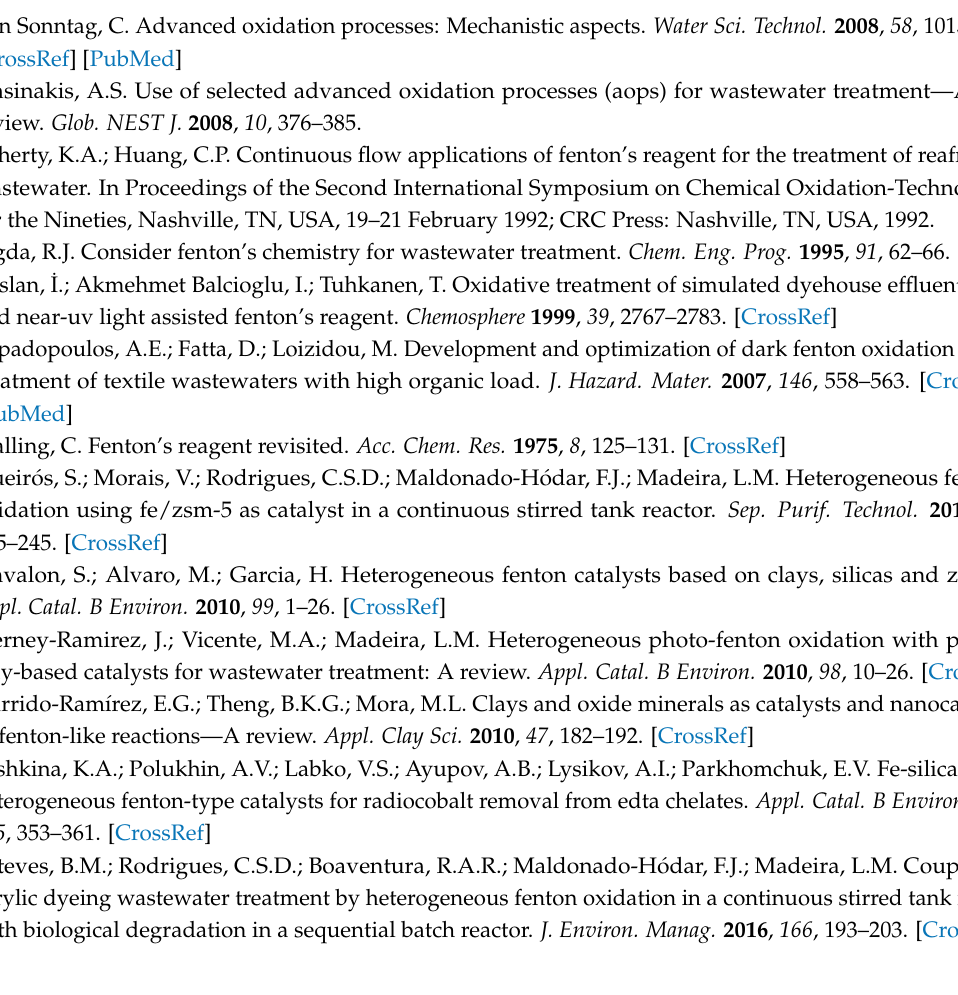
Figure S1: Correlation between specific surface area and the PNP removal after 2 h of adsorption with the carbon supports undoped (a) and N-doped with melamine (b) (pH = 3.0, T = 30 ◦ C, [support] = 0.25 g L − 1 and [PNP] = 3.6 mmol L − 1 ). Figure S2: PNP (a) and TOC (b) removal after 2 h of adsorption or Fenton’s oxidation in presence of DMSO with the catalysts (pH = 3.0, T = 30 ◦ C, [catalyst] = 0.25 g L − 1 , [H 2 O 2 ] when used = 29 mmol L − 1 , [PNP] = 3.6 mmol L − 1 and H 2 O 2 :PNP molar ratio = 8.1, when H 2 O 2 was used). Figure S3: Relationship between PNP removal after 2 h of Fenton reaction and N-amount of N-doped xerogels (pH = 3.0, T = 30 ◦